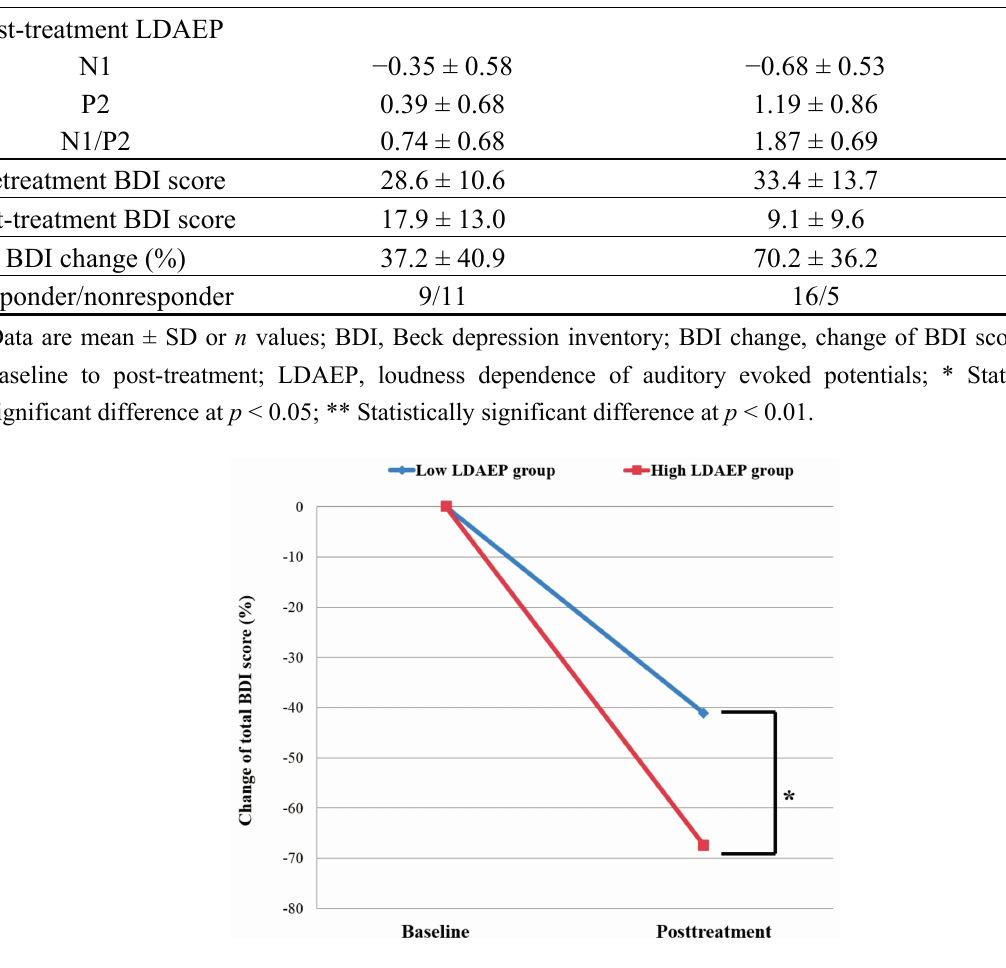
Figure 3. Changes in the total BDI score between baseline and follow-up in MDD patients dichotomized according to their pretreatment LDAEP ( i.e ., low or high). The change in total BDI score differed significantly between the low- and high-LDAEP groups ( t = − 2.741, p = 0.009). BDI change, change in BDI score from baseline to follow-up. * Statistically significant difference at p <